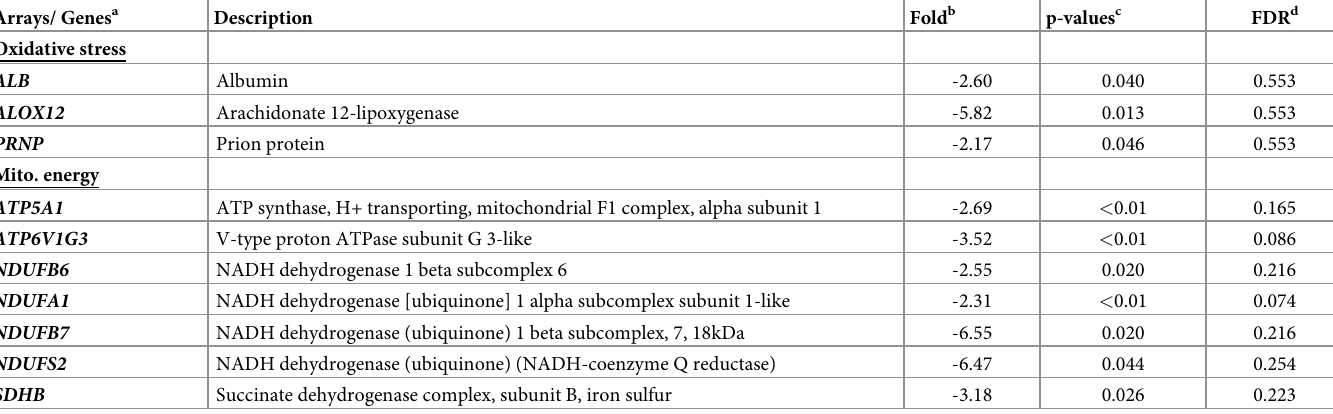
a RT 2 -profilers used were oxidative stress and mitochondrial energy metabolism (mito. energy) and each array included 84 genes. b Fold change (2 - ΔΔ Ct ) is the normalized gene expression (2 - Δ Ct )) at d 23 divided the normalized gene expression (2 - Δ Ct ) at d 14. Fold-change values greater than one indicates a positive- or an up-regulation and values less than one indicate a negative or down-regulation. c The p values are calculated based on a Student’s t-test of the replicate (2 - Δ Ct ) values for each gene from NBW piglets of both ages. d The FDR is the False Discovery Rate adjusted